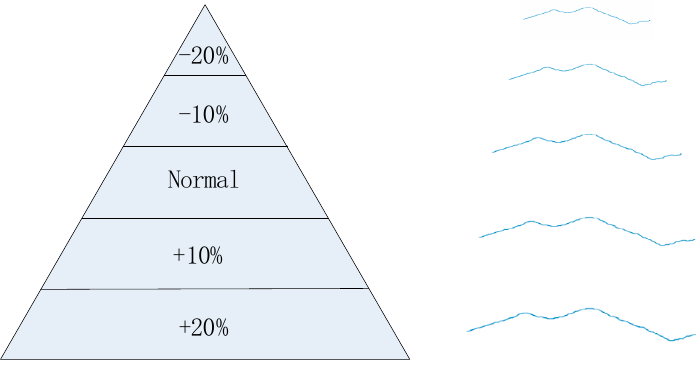
Figure 21. Image skyline pyramid ( left ) and the corresponding skylines ( right ).